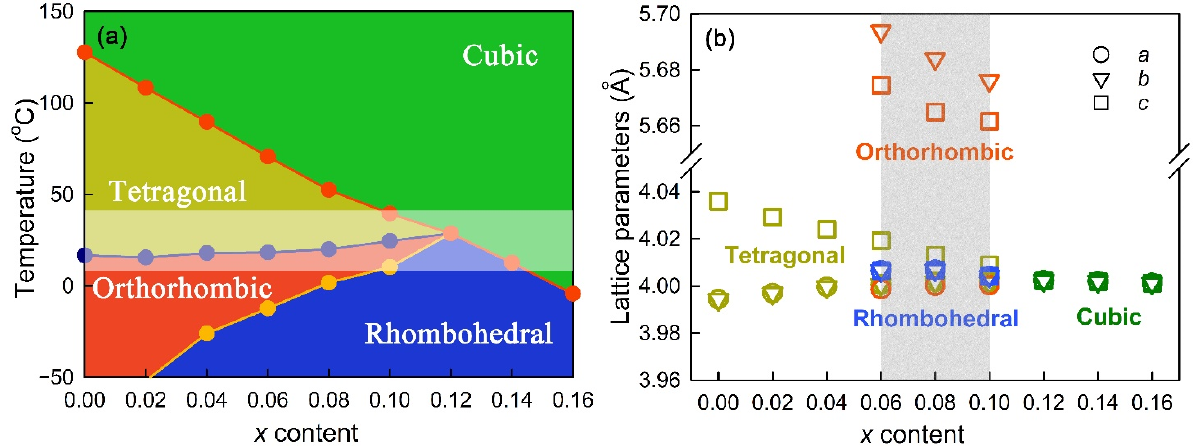
Figure 4. ( a ) Phase diagrams, and ( b ) lattice parameters as a function of CS